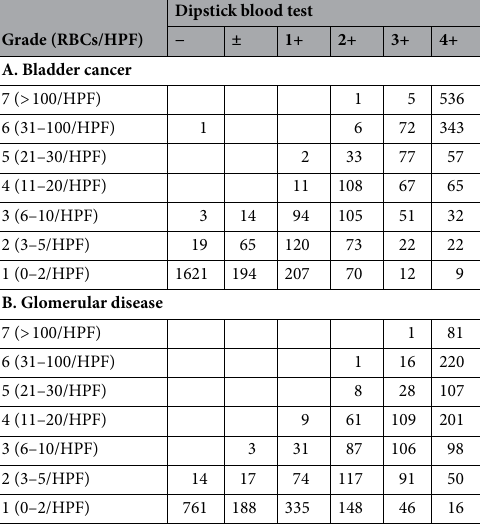
Table 1. The distributions of urine RBC counts measured using the UF-1000i urine analyzer at each positive degree of dipstick blood test in patients with bladder cancer (A) and glomerular disease (B). RBCs red blood cells, HPF high power